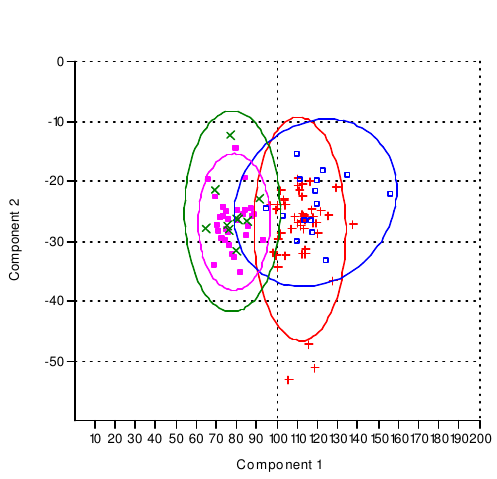
Fig. 10. PCA scatter diagram (using 95% ellipses) of the meristics of the right side of wild and cultured Clarias gariepinus of both sexes, showing incomplete overlap of traits * Red color indicates wild population (male), blue color indicates wild population (female), pink color indicates cultured population (male) and green color indicates cultured population